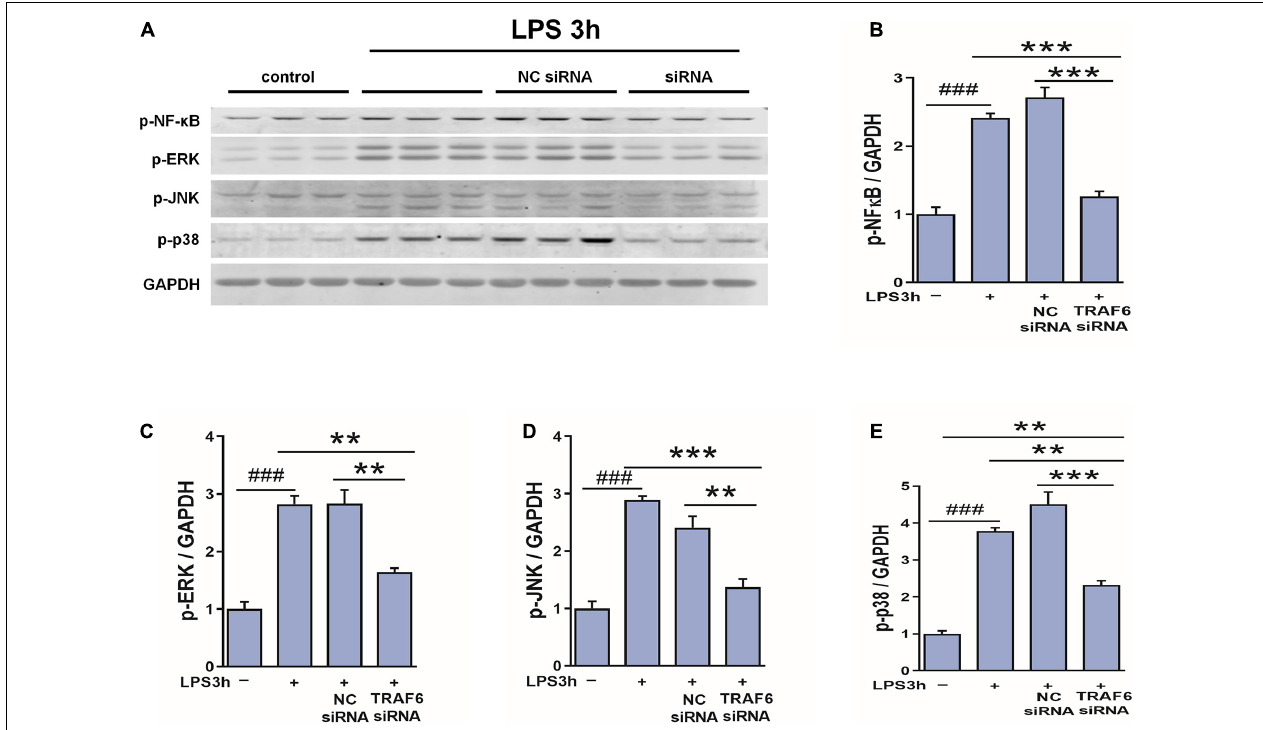
FIGURE 10 | TRAF6 knockdown partially suppressed LSP-induced upregulation of p-NF- κ B, p-JNK, p-ERK, and p-p38 in cultured astrocytes. (A) Western blot analysis was used to detect the expression of p-NF- κ B, p-ERK, p-JNK, and p-p38. GAPDH was used as an internal control. (B–E) The optical density of the bands was analyzed by ImageJ. ** P < 0.01 and *** P < 0.001 vs. TRAF6 siRNA group. ### P < 0.001 vs. control